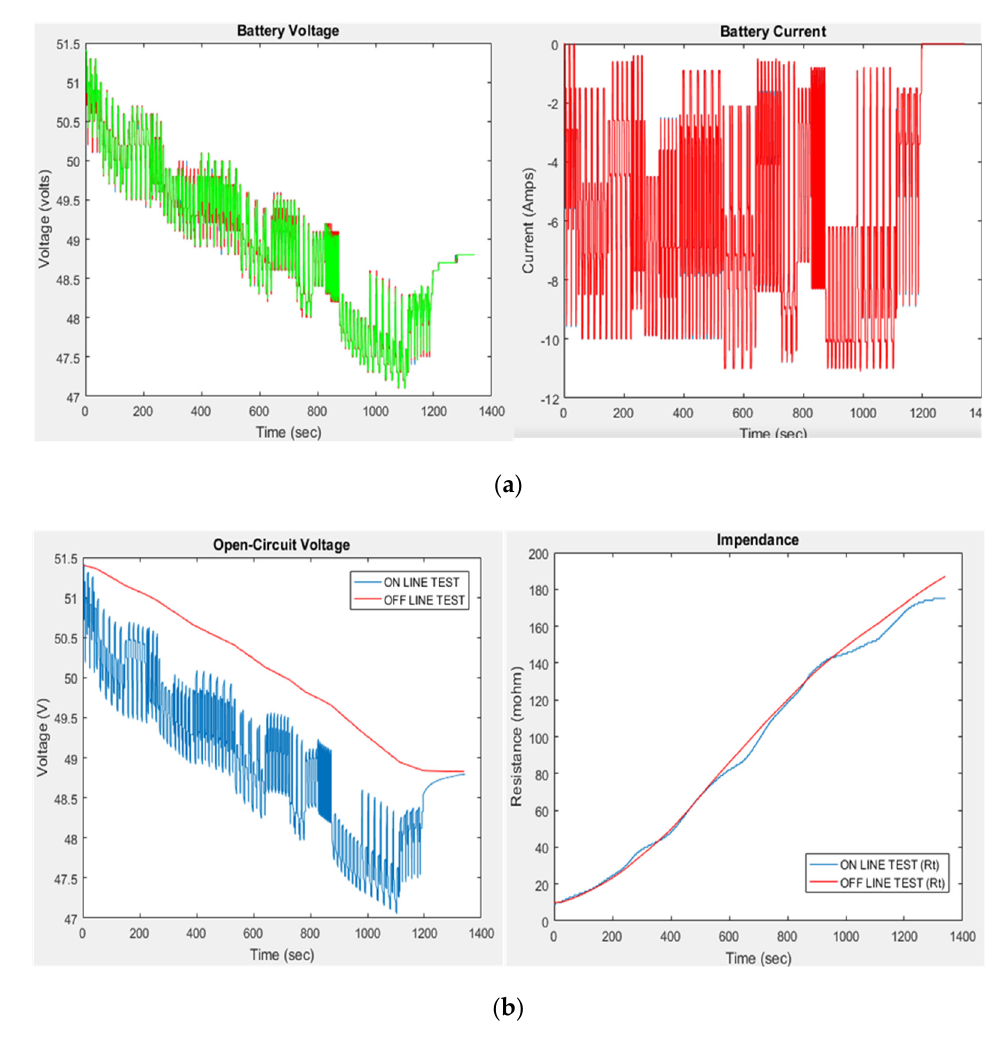
Figure 11. ( a ) Voltage drop and discharge current; ( b ) comparison of online estimating OCV and Rt with the offline numerical model.